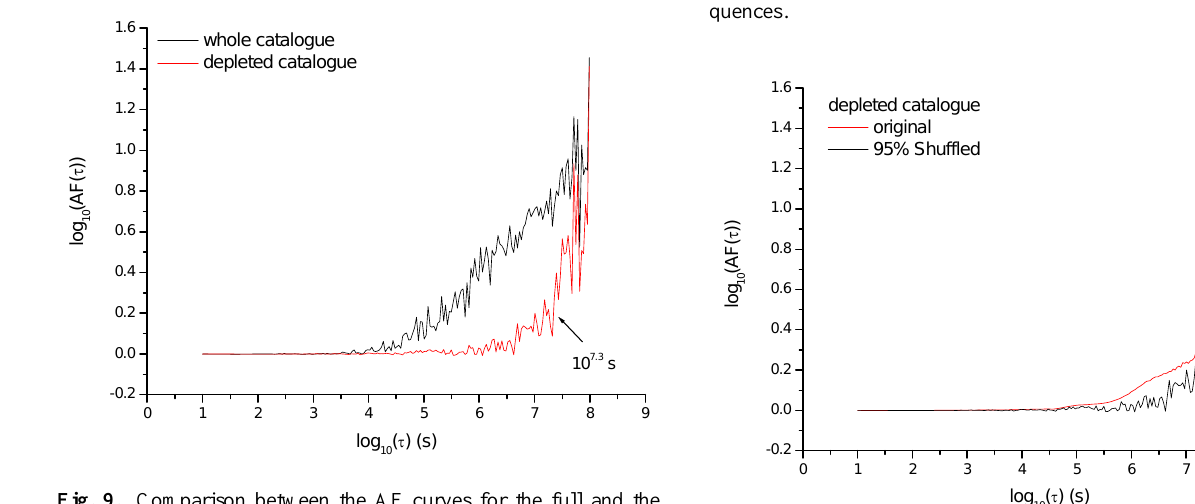
Fig. 9. Comparison between the AF curves for the full and the aftershock-depleted catalogues.